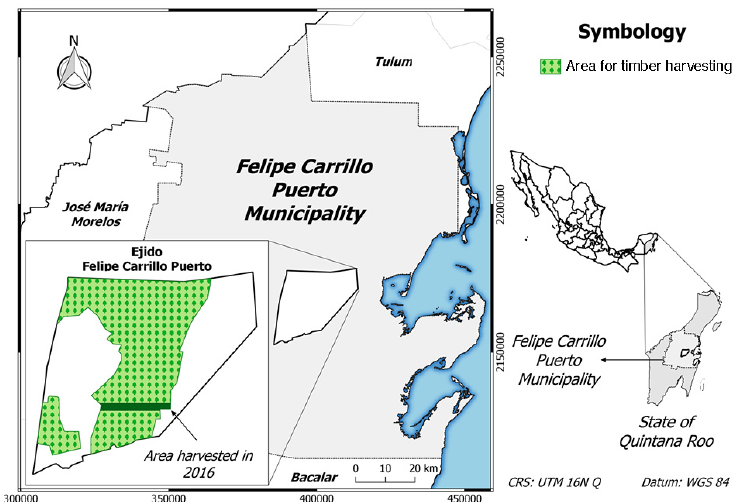
Figure 1. Map of the study area in Felipe Carrillo Puerto, Quintana Roo, Mexico, and of the area harvested in 2016. The area harvested is defined by the coordinates 19.5376 N, 87.9992 W; 119.5378 N,